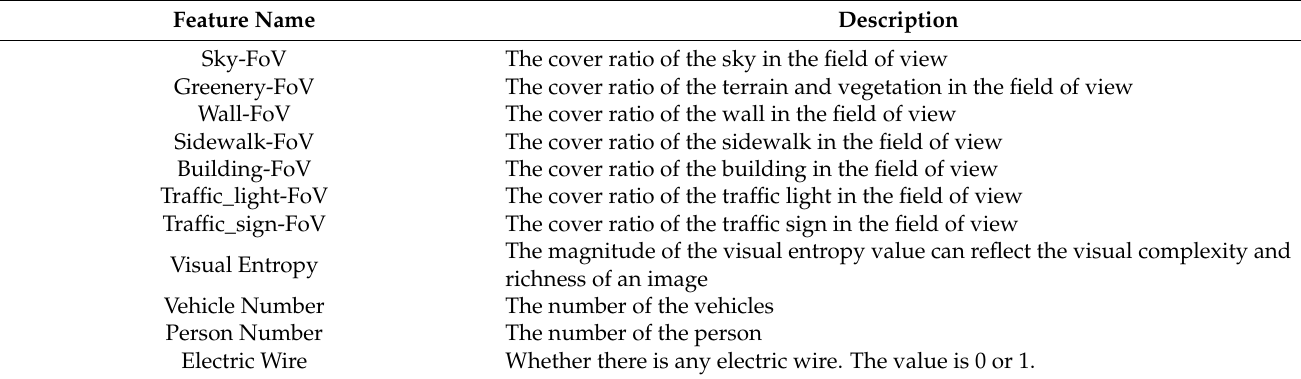
Table 1. Specific definitions of street view visual